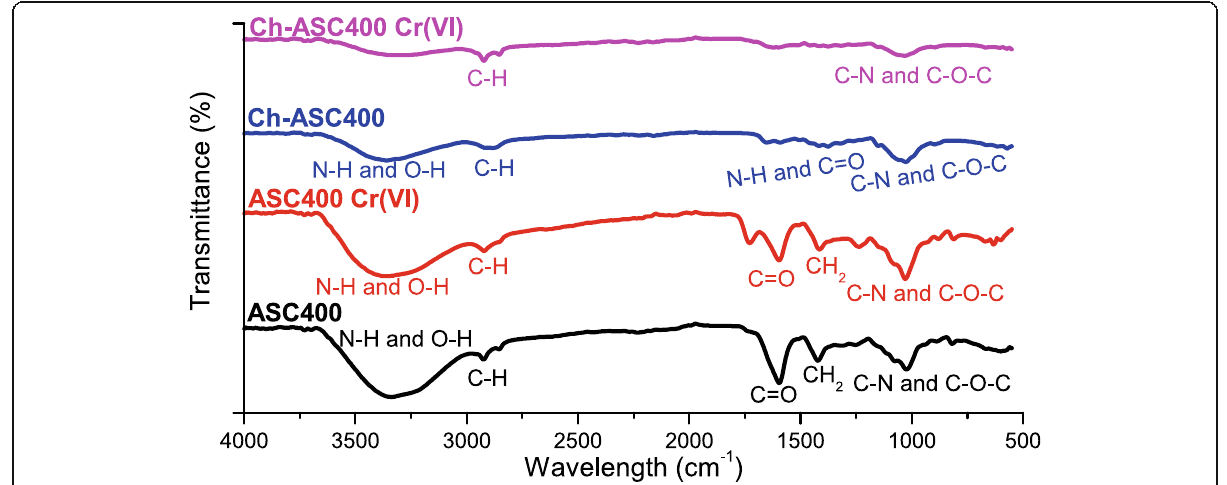
Fig. 1 FTIR spectra of ASC400 and Ch-ASC400 before and after Cr(VI) adsorption